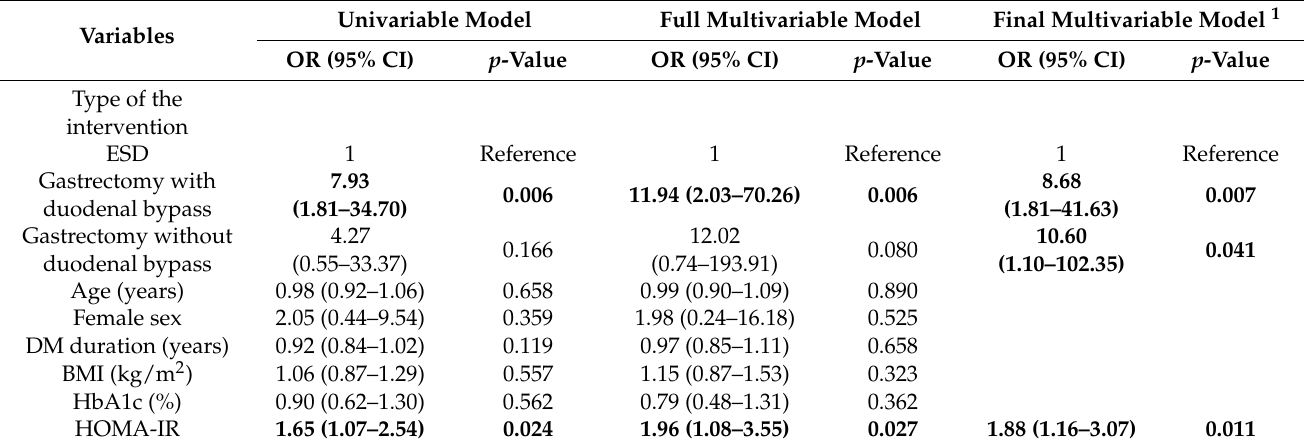
Table 2. The effects of gastrectomy with or without duodenal bypass on the probability of better glycemic control at the 1-year